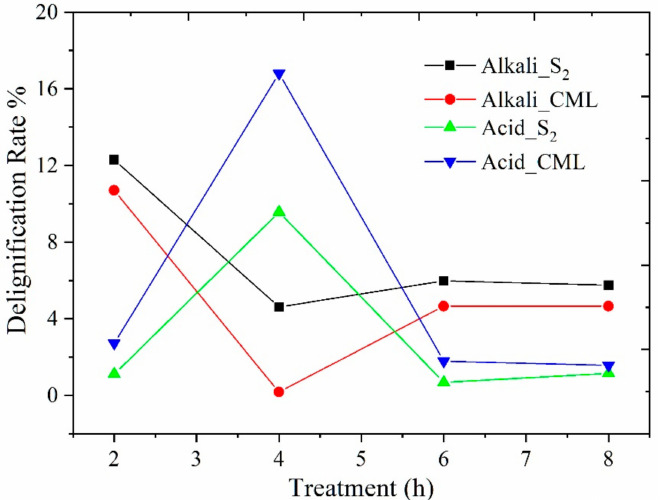
Figure 3. Delignification rate over time for alkali and acid gradient-treated cell